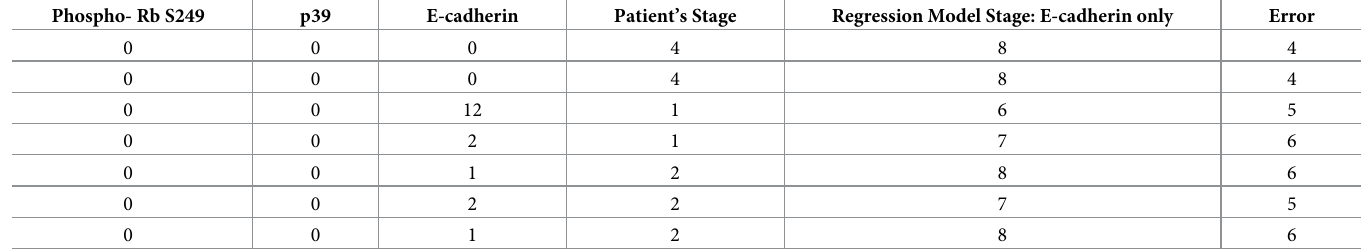
Table 7. A random sample of SCC tumors from our TMAs were selected to calculate tumor staging using our linear regression model when considering only E-cad- herin score. The tables show the score for phospho-Rb S249, p39, E-cadherin and the patient´s tumor stage ( first fourth columns , respectively ). The fifth column shows the stage predicted by our linear regression analysis only when considering E-cadherin. The Error (sixth) columns in all five tables show the difference between the vendor score and our linear regression analysis score, a value of 0 indicating identical scores, while a number other than 0 means that the two scores were different by a magnitude equal to the number indicated in the column. E-cadherin was unable to accurately predict stage in 7 out of 7 samples.